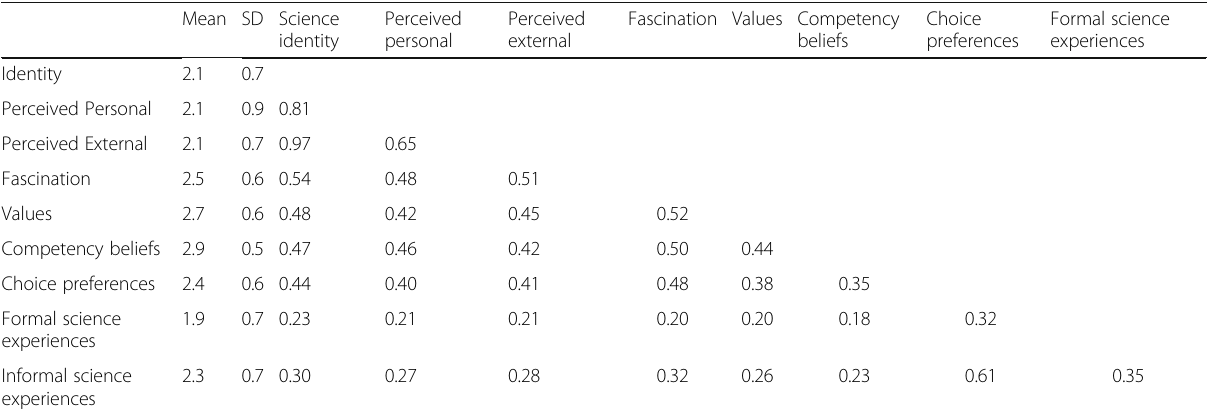
Table 4 Means, SD, and Pearson correlation coefficients among the attitudinal predictors and the optional science learning measures